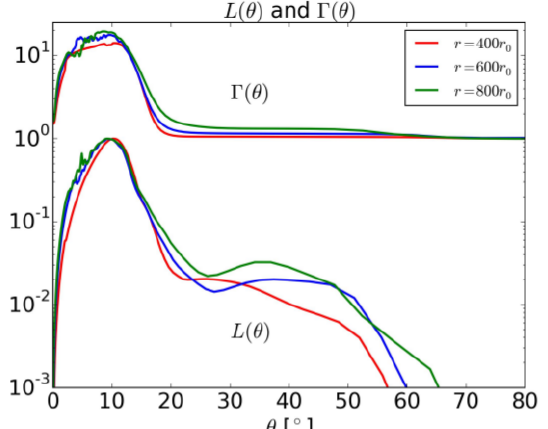
Figure 13. The appearance of a jet model after break out from the BNS ejecta. A model from [211]. This figure presents the jet luminosity Λ ( θ ) (in arbitrary units) and Lorentz factor as a function of the observer’s angle. Quantities are extracted at three different radii. It is evident that even for angles greater than 20 ◦ , the luminosity is reduced but still significant. (Reprinted from [211]. c (cid:13) Oxford University Press. Reproduced with